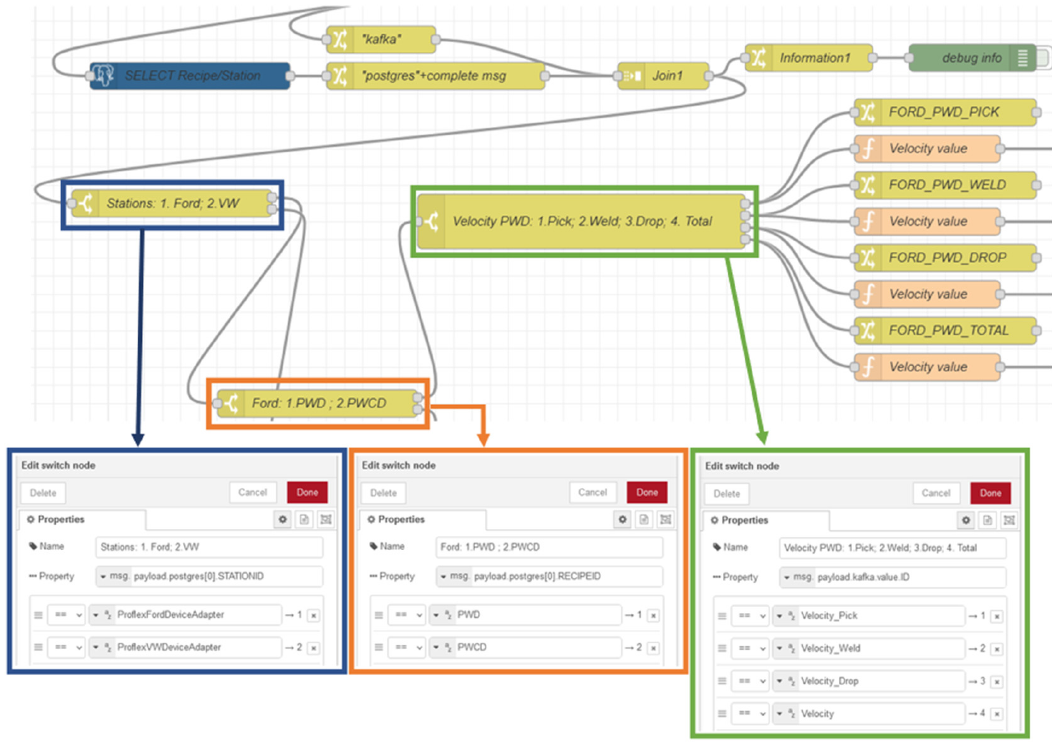
Figure 13. Switch nodes used for routing the messages using the Ford station as example. In the edit switch node, from left to right, we have: Stations: 1. Ford; 2. VW, Ford: 1. PWD; 2. PWCD and